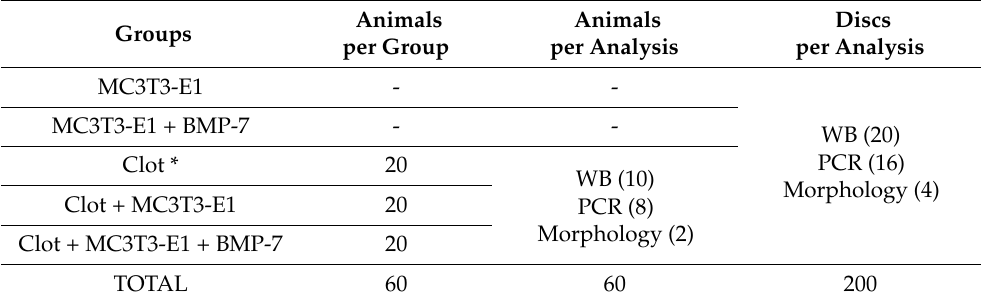
Table 1. Descriptive table of the number of animals and discs per group and per analysis. Western blotting (WB); real-time polymerase chain reaction (real-time PCR); morphology (epifluorescence and scanning electron microscopy). Animals Animals Discs Groups per Group per Analysis per Analysis MC3T3-E1 - - MC3T3-E1 + BMP-7 - - WB (20) PCR (16) 20 WB (10) Morphology (4) PCR (8)